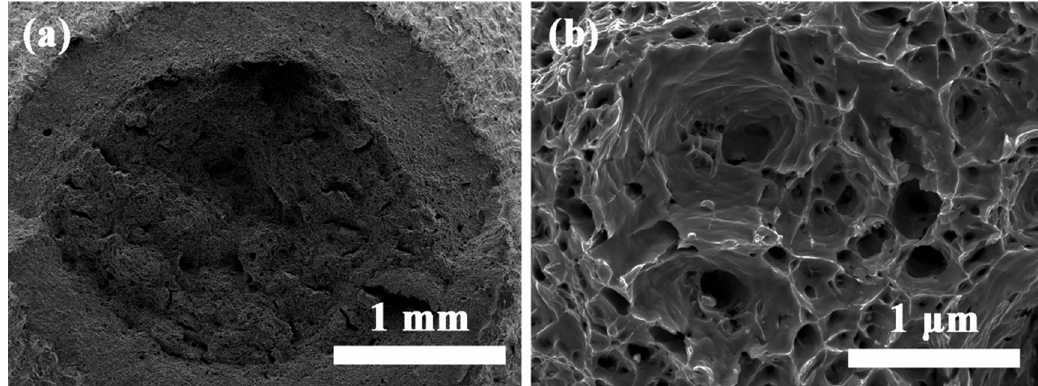
Figure 9. SEM images of the fracture surface of the tensile tested samples: ( a ) macro-morphology and ( b ) micro-morphology of fracture in the as-TMTed alloy after tensile tests at 25 °C.